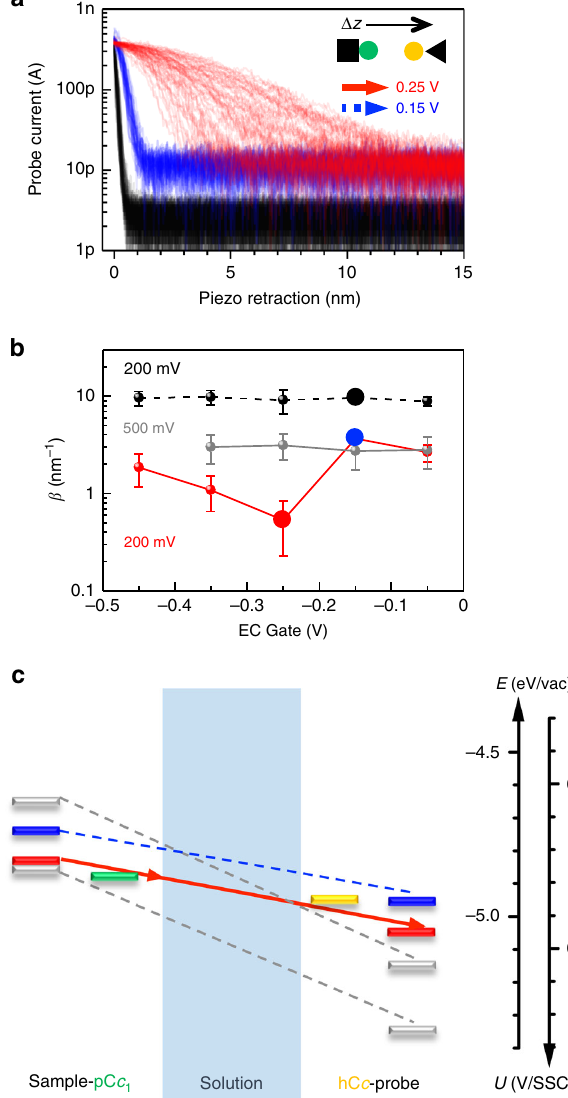
Fig. 3 Electrochemical gating of long-distance electron transfer between pC c 1 and hC c . a I-z plots at 200 mV constant bias for pC c 1 – hC c at U P = 0.45 V and U S = 0.25 V (red), and at U P = 0.35 V and U S = 0.15 V for pC c 1 – hC c (blue) and for bare gold (black). Red curves ( β = 0.5 ± 0.3 nm − 1 ) show long- distance ET beyond 10 nm. b Averaged β values (mean ± SD of N = 80) vs. EC gate potential at 200 mV constant bias for bare gold (black) and pC c 1 – hC c (red), and at 500 mV constant bias for pC c 1 – hC c (gray). Colored data points correspond to curves shown in a . c Energy diagram of ET processes for pC c 1 – hC c in the conditions shown in a and b (red: U P = 0.45 V, U S = 0.25 V; blue: U P = 0.35 V, U S = 0.15 V). ET processes at 500 mV constant bias are shown in gray ( U P = 0.55 V, U S = 0.05 V; U P = 0.75 V, U S = 0.25 V). Fermi energies (sample, probe, and pC c 1 and hC c redox levels) are in the absolute energy scale E (eV) = – e· U (V/SSC) −